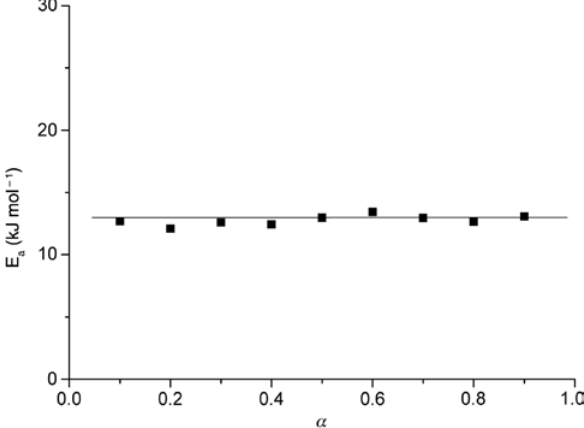
, versus degree of caffeine a